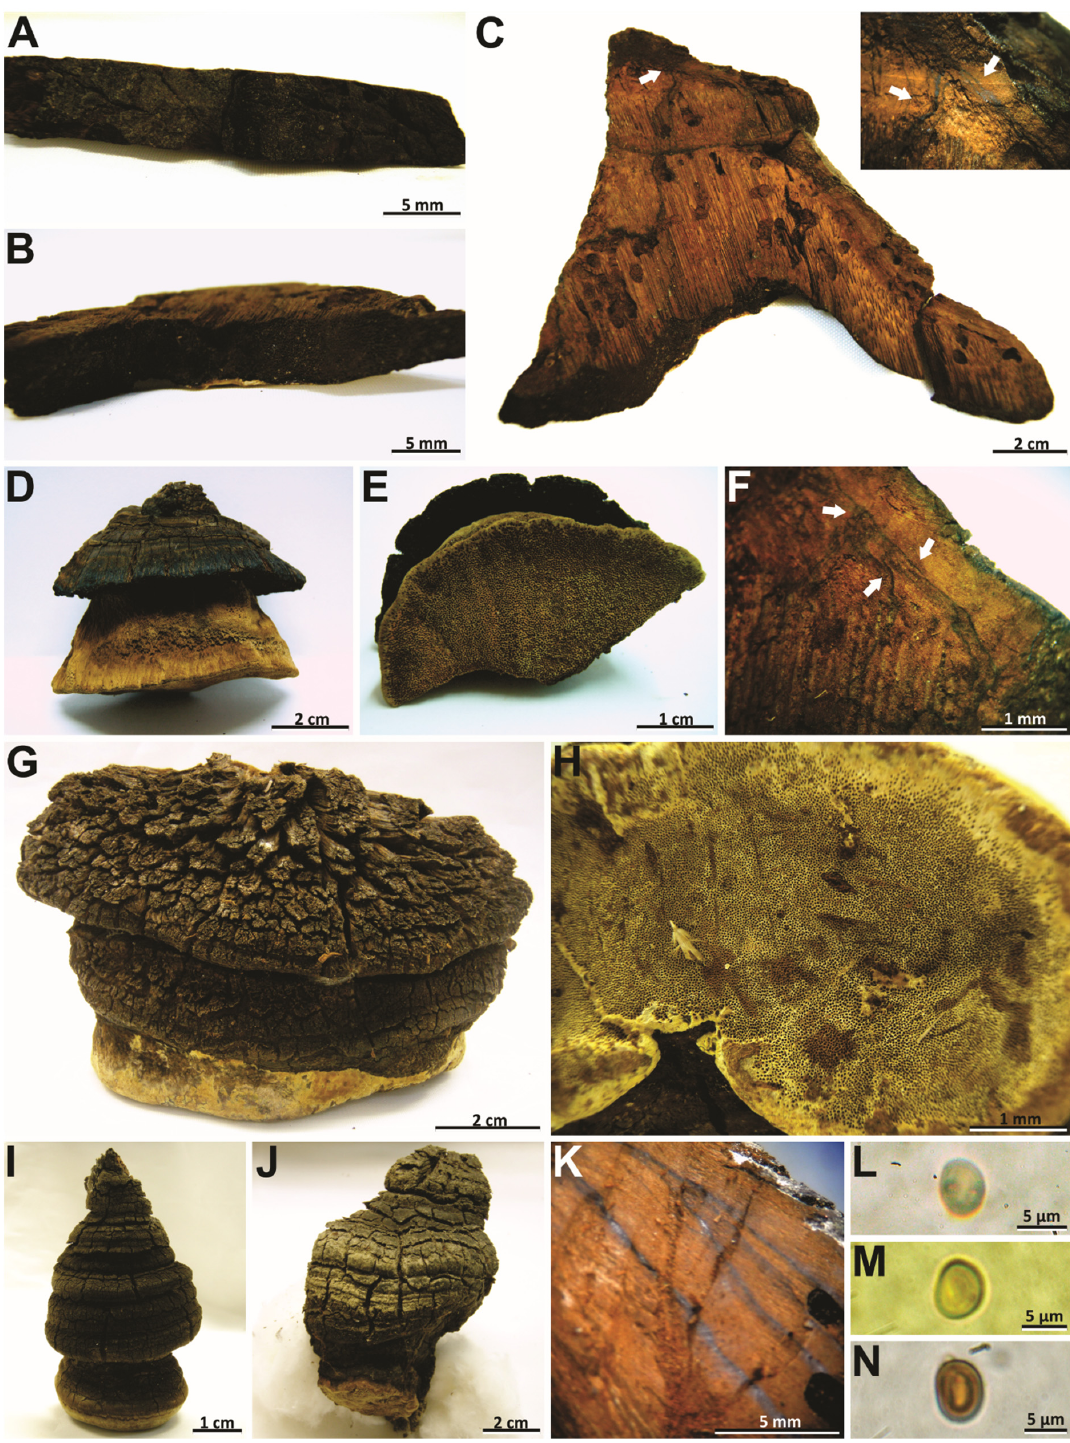
Figure 9. Morphological features of Phellinotus scaber . ( A – C ) K–M: 180666 (lectotype). ( A ) Pileal surface; ( B ) pore surface; ( C ) perennial basidioma with concave pore surface and dark lines in context; ( D – F ) MEL 229175. ( D ) Basidioma with cracked pileal surface; ( E ) concave and brown pore surface; ( F ) context with dark lines; ( G , H ) MEL 2359296. ( G ) Basidioma with rimose pileal surface; ( H ) concave and olive brown pore surface; ( I ) MEL 2264870; ( J , K ) MEL 2032383. ( J ) Basidioma; ( K ) context with dark lines; ( L – N ) basidiospores ( K – M : 180666, lectotype). ( L ) In water; ( M ) in Melzer’s reagent; ( N ) in